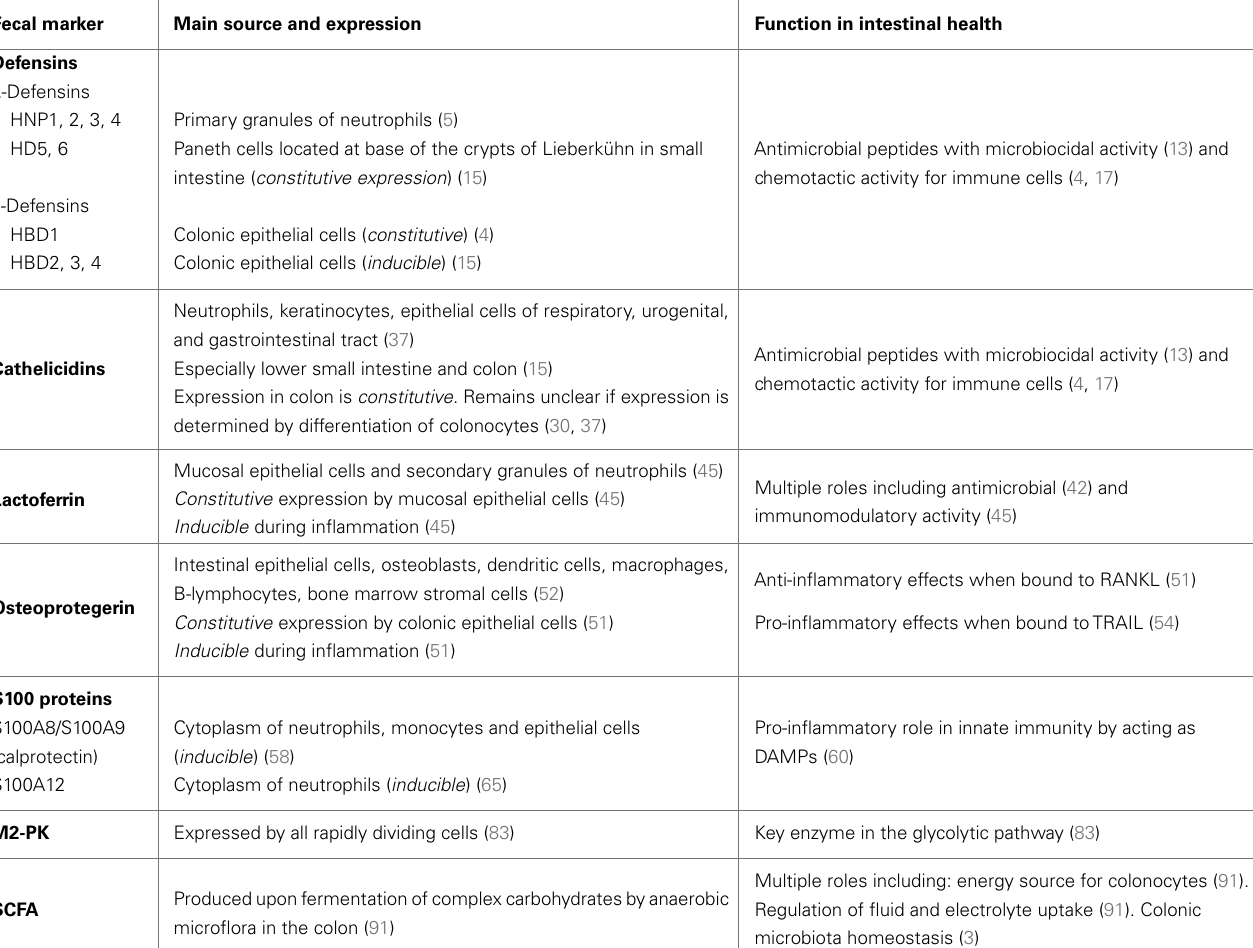
Table 2 |The expression and function of defensins, cathelicidins, lactoferrin, OPG, S100 proteins, M2-pyruvate kinase (M2-PK), and short-chain fatty acids